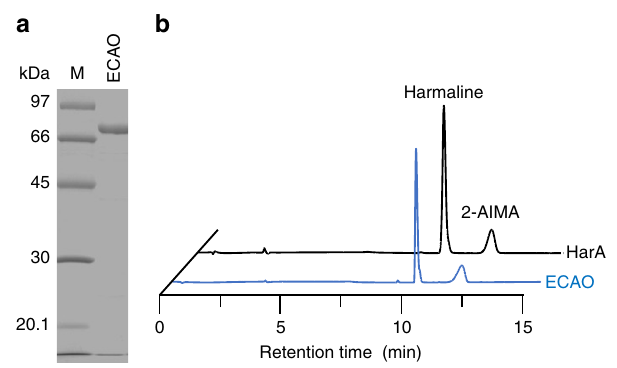
Fig. 6 Harmaline-degrading activity of copper amine oxidase from E. coli . Copper amine oxidase (CAO) from E. coli (ECAO) was overexpressed in E. coli and puri fi ed. a SDS-PAGE of puri fi ed ECAO. Source data are provided as a Source Data fi le. b Harmaline-converting activity of ECAO. The concentrations of HarA and ECAO were 0.5 mg mL − 1 . Lane M,